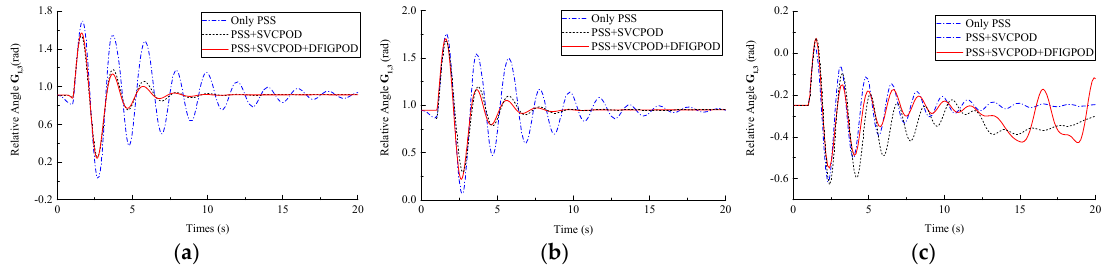
Figure 13. System bus 7 3-phase fault responses under different system operating scenarios. ( a ) Line 7–8 outage; ( b ) Line 8–9 outage; and ( c ) Tie-line active power is − 310 MW.